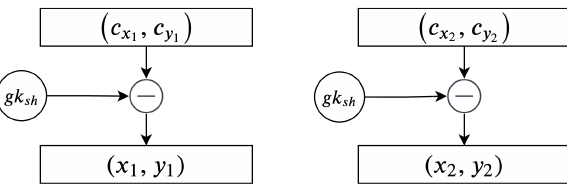
Figure 11. Decrypting secured points using the shared group key.